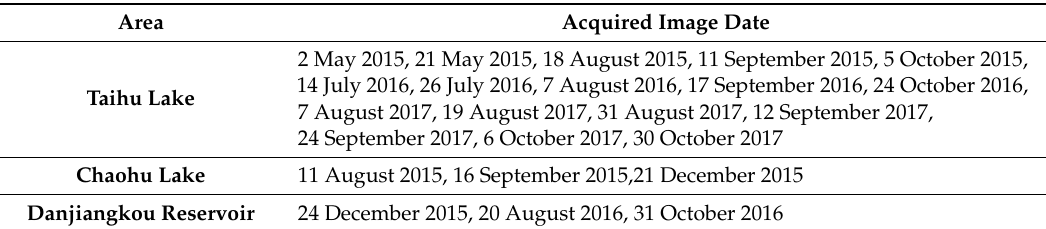
Table 1. Acquired SAR images used in this study.